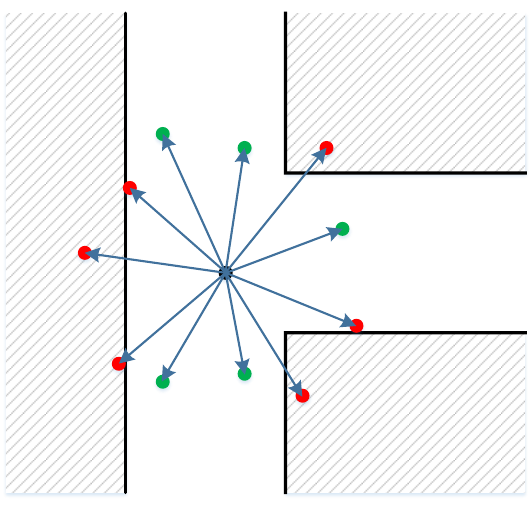
Figure 4. A simple moving model with the black dot being the initial particle. The walls are used as a constraint to remove bad constraint to remove bad particles.